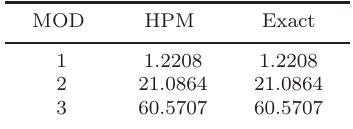
Table 1. Normalized buckling loads for the first three modes for the columns with a constant flexural stiffness ( a/L = 0 . 8) .